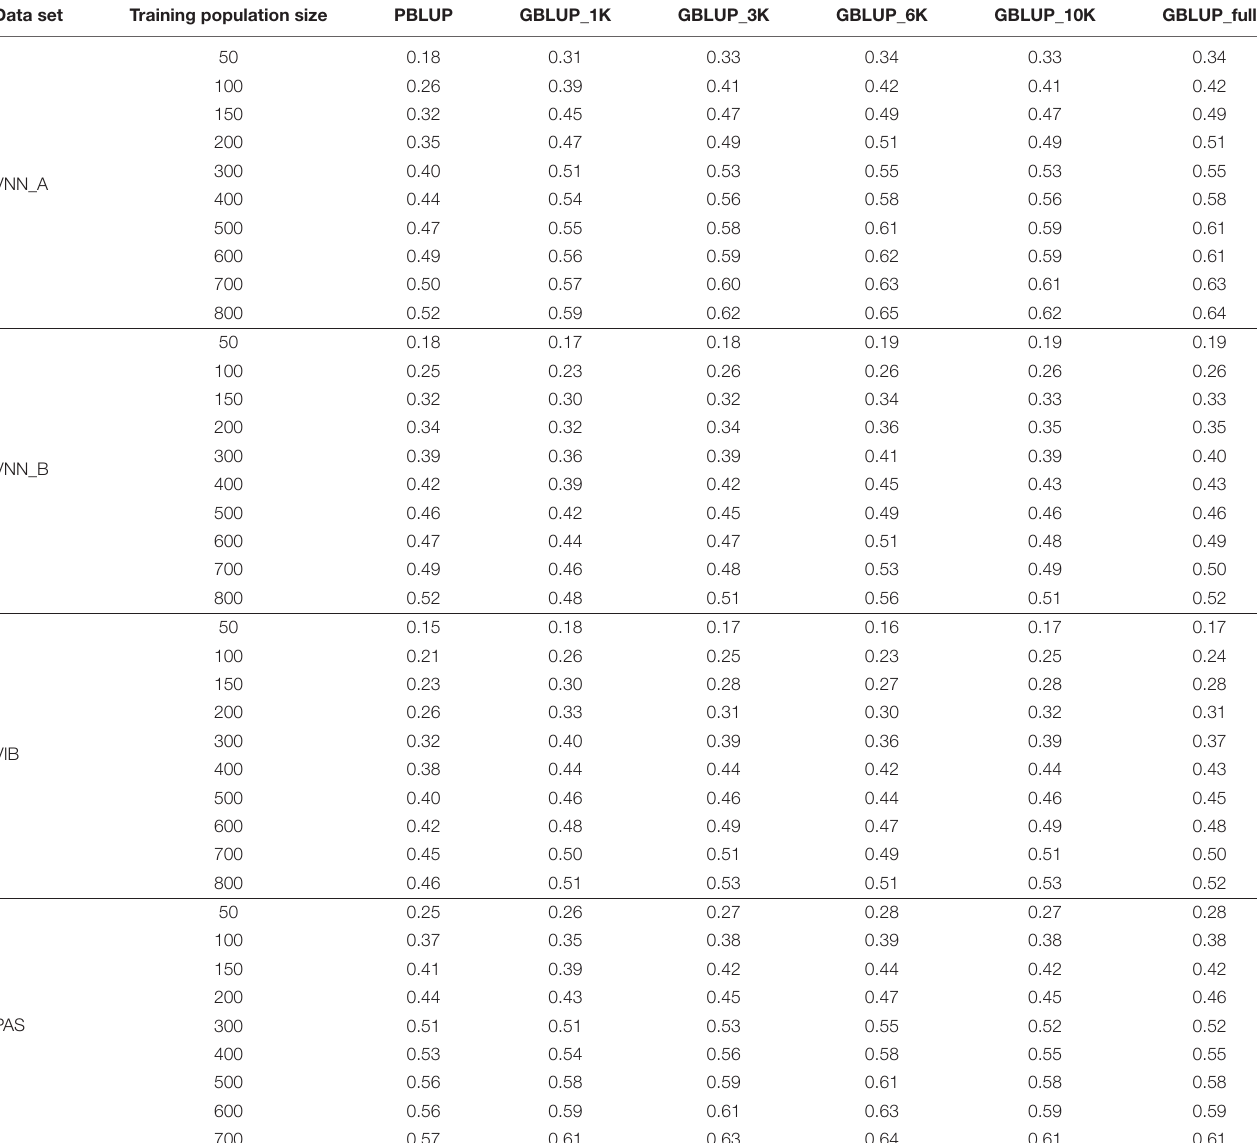
TABLE 3 | Prediction accuracy for VNN resistance in two European sea bass commercial cohorts (VNN_A and VNN_B), vibriosis resistance in one European sea bass commercial cohort (VIB) and pasteurellosis resistance in one gilthead sea bream commercial cohort (PAS) using different training population sizes and marker densities. Data set Training population